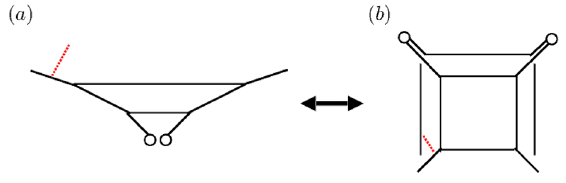
Figure 22 . The web diagrams after the geometric transition. Since we move two D7-branes, the shape of framing after moving the D7-branes is more complicated than previous case depicted in figure 20. Open